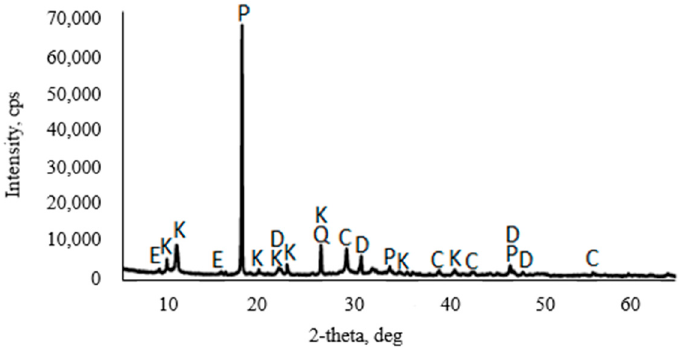
Figure 2. XRD image of dry concrete sludge: C—calcite; P—portlandite; D—dolomite; Q—quartz; E—ettringite; K—kuzelite.